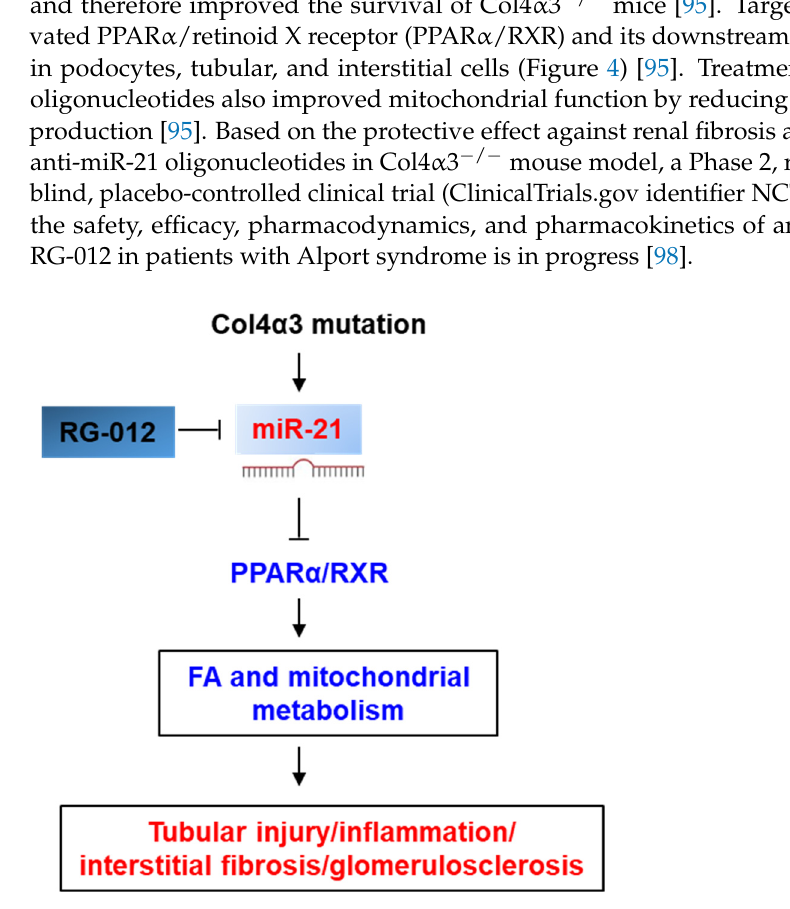
Figure 4. Signaling pathways modulated by miR-21 in Alport syndrome. miR-21 is upregulated in glomeruli and renal tubules in kidneys from patients with Alport syndrome, and in kidneys from Col4 α 3 − / − mouse model. The upregulation of miR-21 inhibits the expression of PPAR α /retinoid X receptor (PPAR α /RXR) and its downstream signaling pathways, leading to a dysfunction of fatty acid and mitochondrial metabolism. Treatment with miR-21 antagonism RG-012 improves renal functions by decreasing tubular injury, inflammation, interstitial fibrosis, and glomerulosclerosis in Col4 α 3 − / − mice. The upregulation or activation of mi-R21 and downstream signaling pathways in Alport syndrome is marked in red . The downregulation or inhibition of mi-R21 downstream signaling pathways in Alport syndrome is marked in blue . Arrow indicates a positive effect. “T” indicates a negative effect.